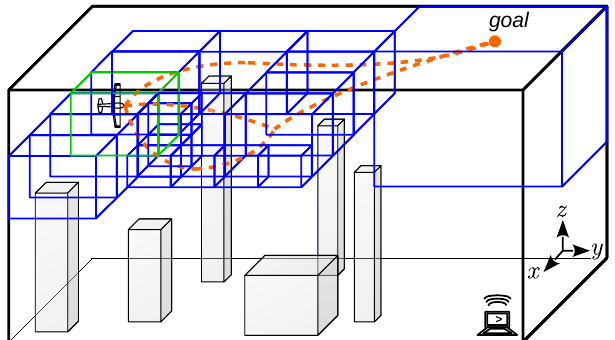
Figure 1. General scenario for 3 D unmanned aerial vehicles (UAV) path planning. The grey cubes depict the environmental obstacles. Blue cubes are generated by the environmental discretisation and represent collision-free spaces. Orange lines are possible